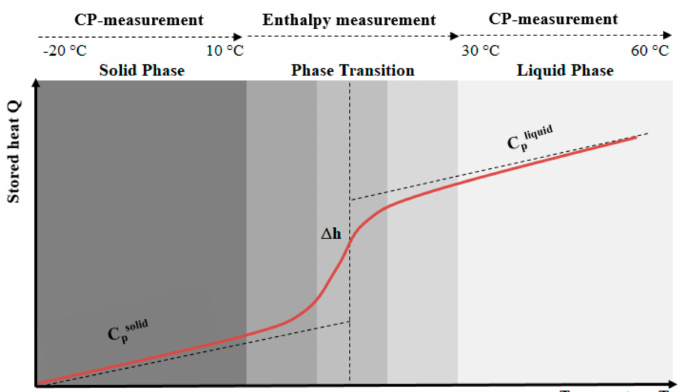
Figure 2. Separation of the measurements in 3 phases: (i) heat (sensible) capacity in solid phase, (ii) heat (latent) capacity under phase change, and (iii) heat (sensible) capacity in liquid phase according to DIN EN ISO 11357-3